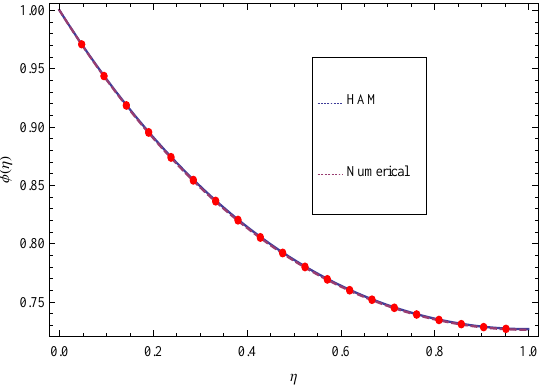
Figure 3. The comparison between HAM and numerical solutions for temperature profile θ ( η ) , when h = − 0.47, λ = 0.2, S = 0.2,kr = 0.2,Pr = 1,Ec = 0.6,Nb = 0.4,Nt = 0.5, β = 1, Sc = 0.5.